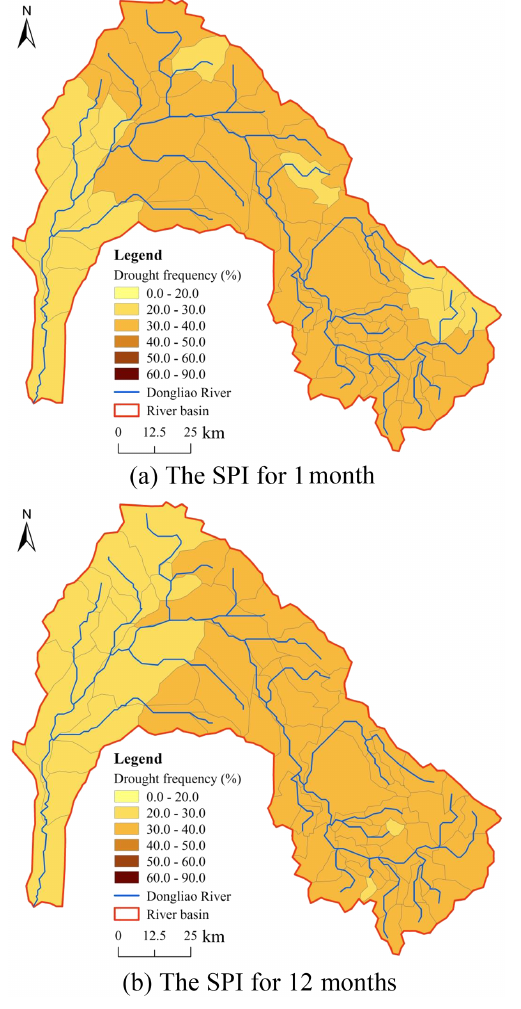
Figure 11. Spatial distribution of drought frequency simulated by the SPI in the DRB.